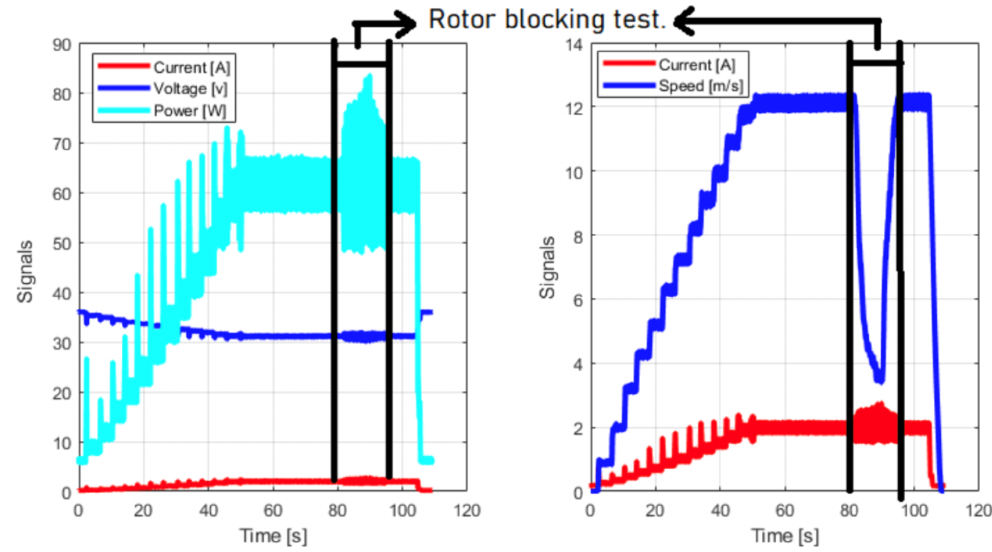
Figure 9. Experimental result of speed curve during rotor blocking test.